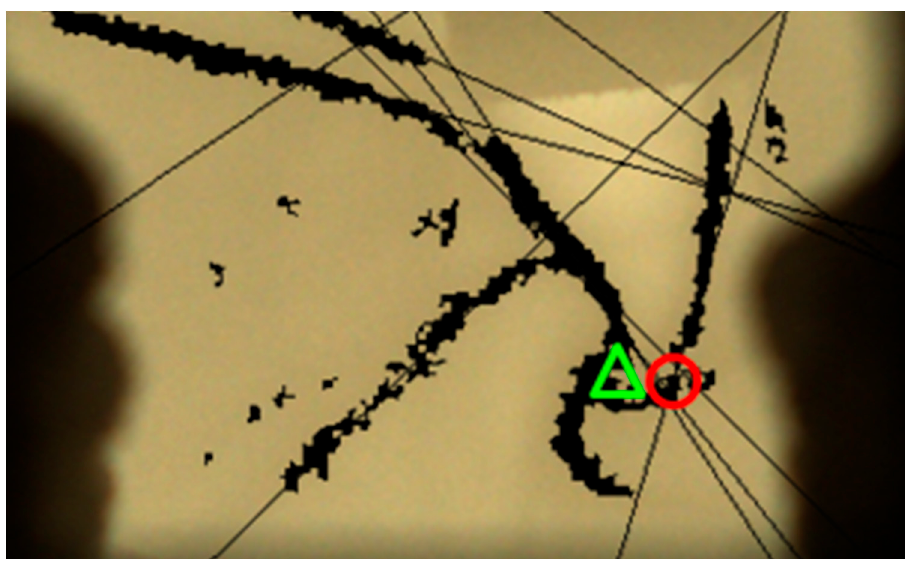
Figure 12. Error detection at the curved parts of stream lines. ( Red : island position, green : position of image processing result).